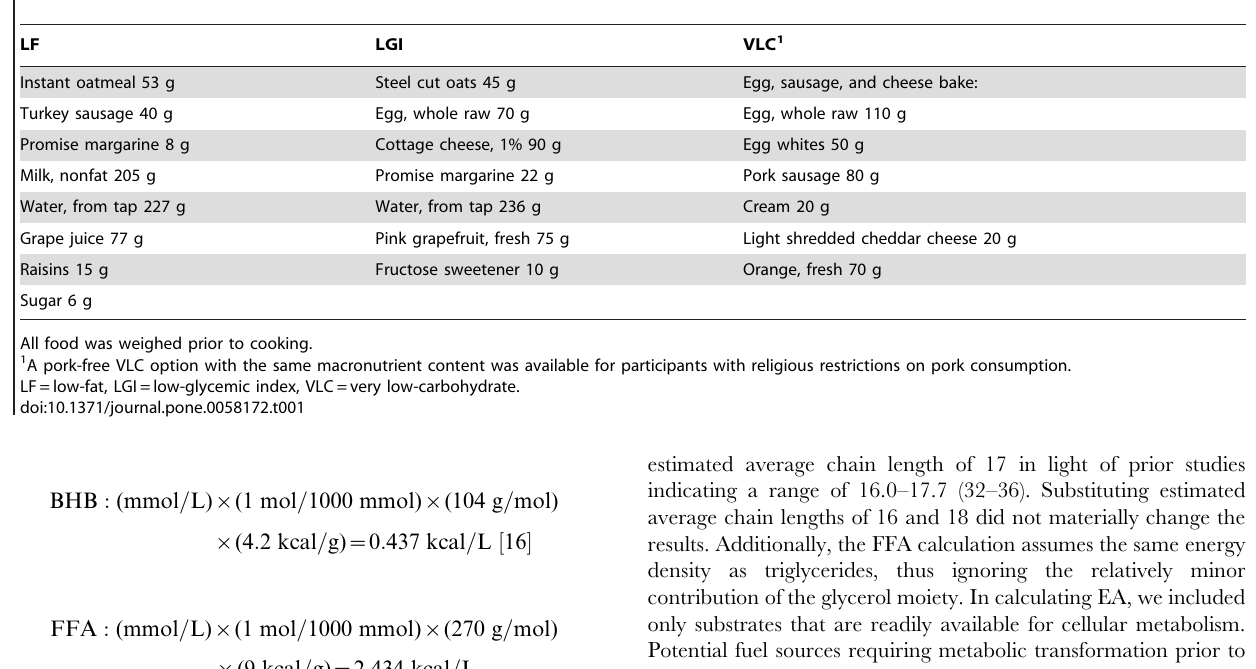
Table 1. Standardized test meals for a 2000 kcal/day diet.